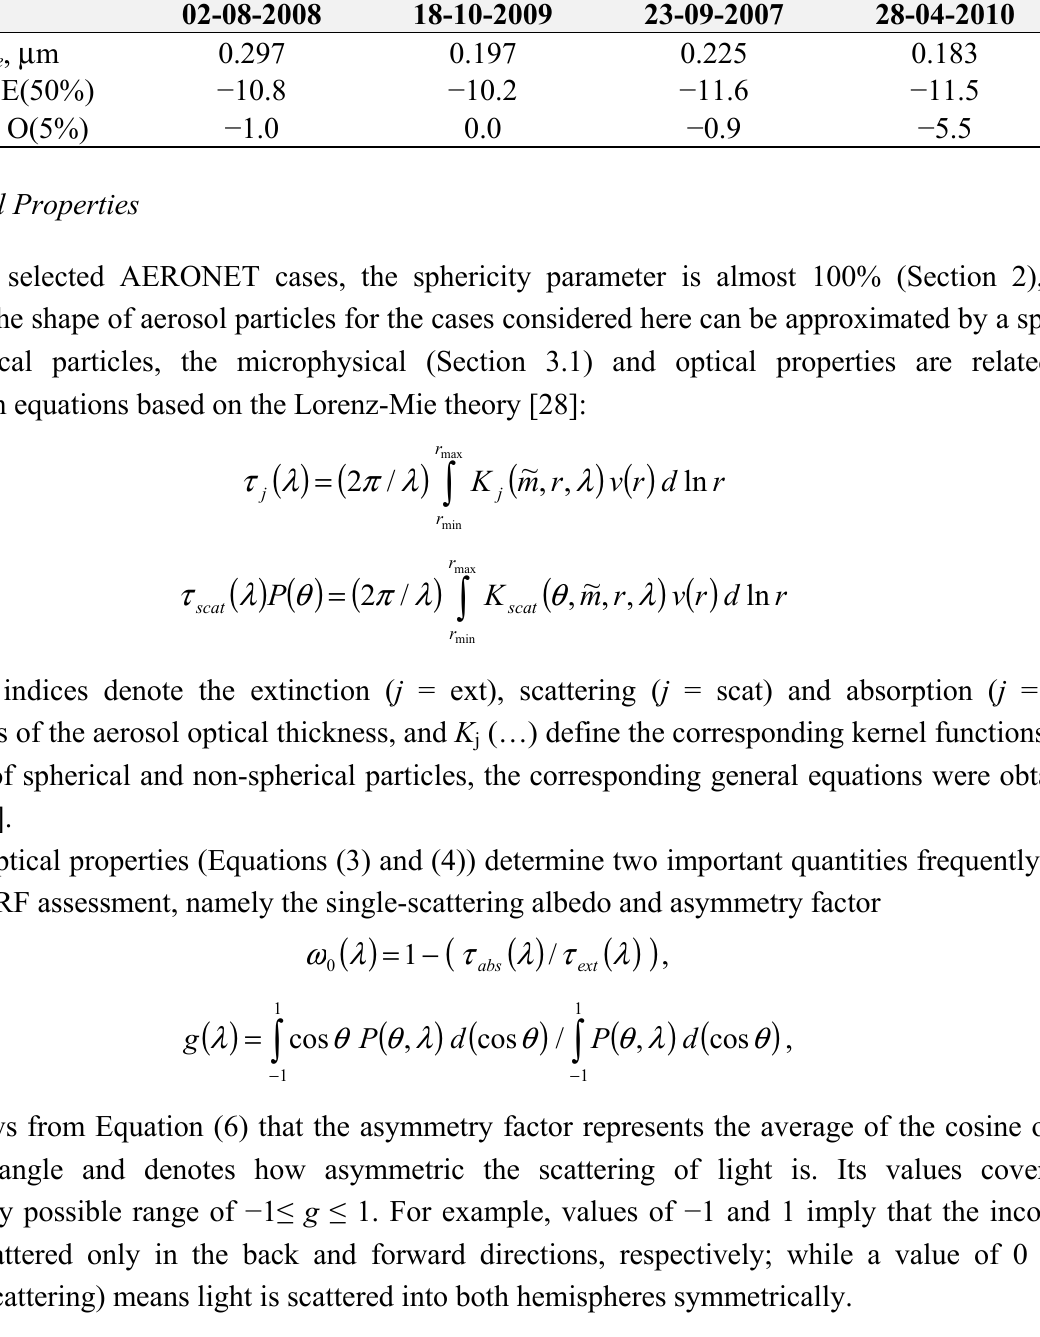
Table 5. The same as Table 3, except that these results correspond to effective radius ( r